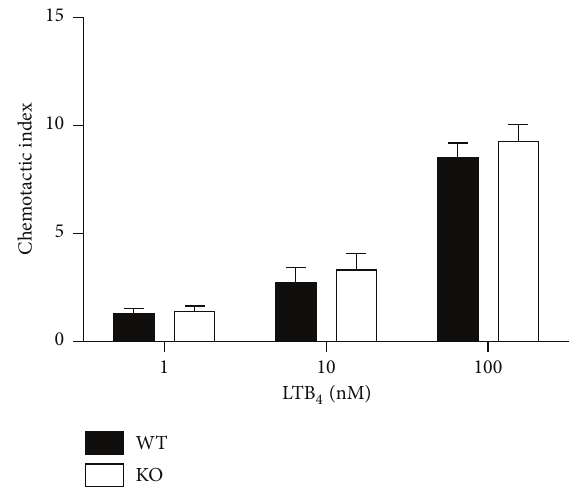
Figure 1: Cyp4f18 knockout neutrophils show no change in LTB 4 - dependent chemotaxis compared to wild-type. Chemotaxis of bone marrow neutrophils from wild-type (WT) and Cyp4f18 knockout (KO) mice was measured using LTB 4 as a chemoattractant. The chemotactic index represents the number of cells migrated in response to LTB 4 divided by background (error bars represent SEM, 𝑛 = 10